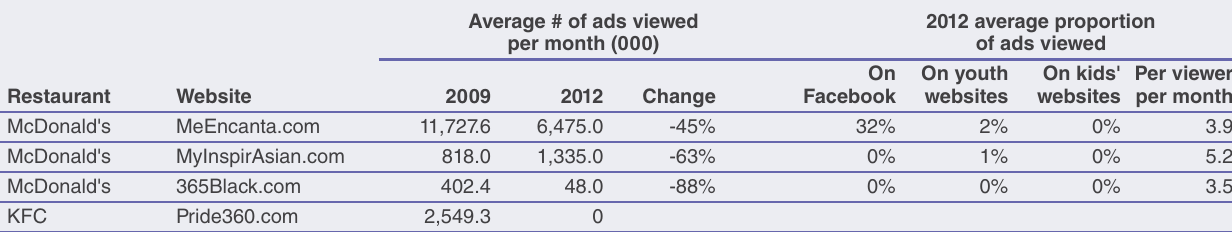
Table 44. Exposure to racial and ethnic targeted display